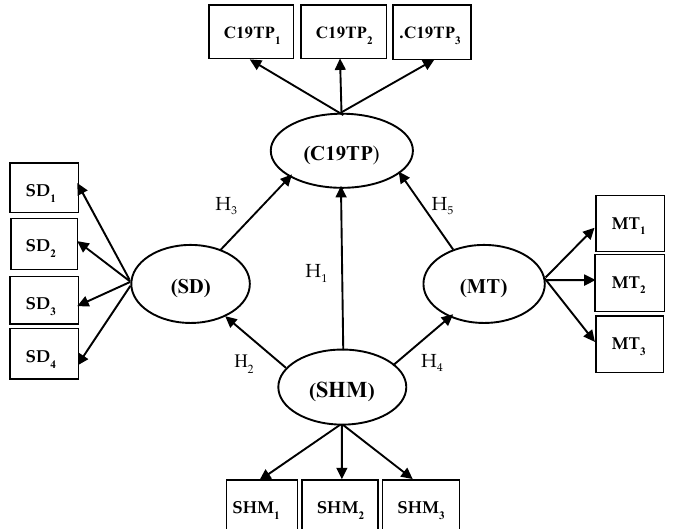
Figure 2. Research model designed. C19TP: drivers for COVID-19 transition period; SD: social distancing; SHM: sanitation and healthcare measures; MT: mass testing.